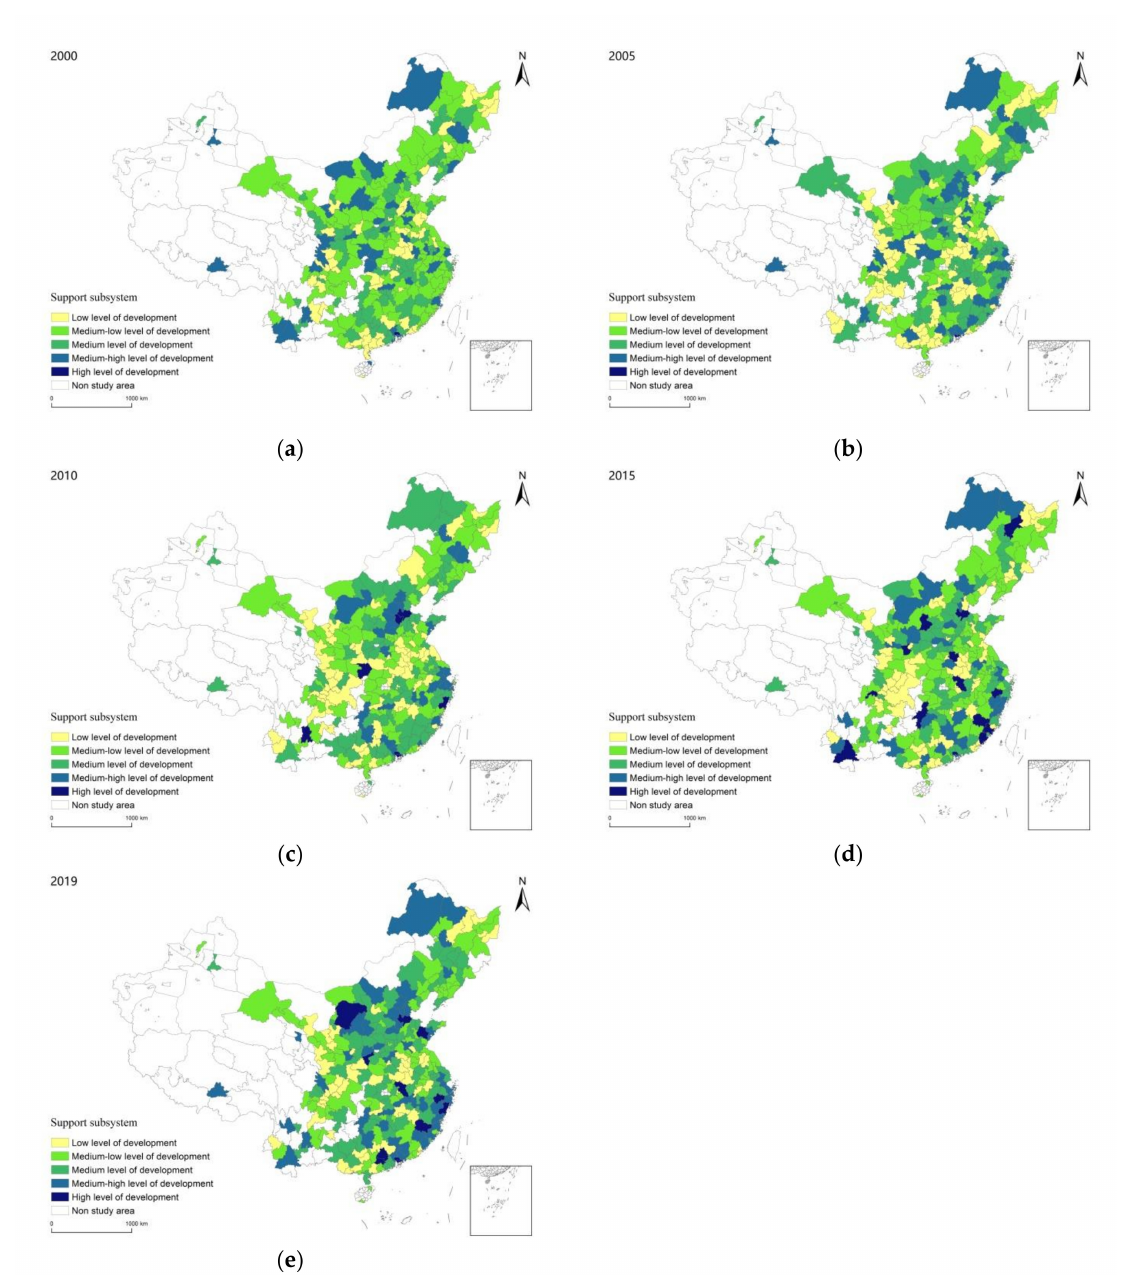
Figure 6. Spatial distribution map of the sustainable development level of the support system of urban human settlements in China. ( a ) 2000; ( b ) 2005; ( c ) 2010; ( d ) 2015; and ( e )